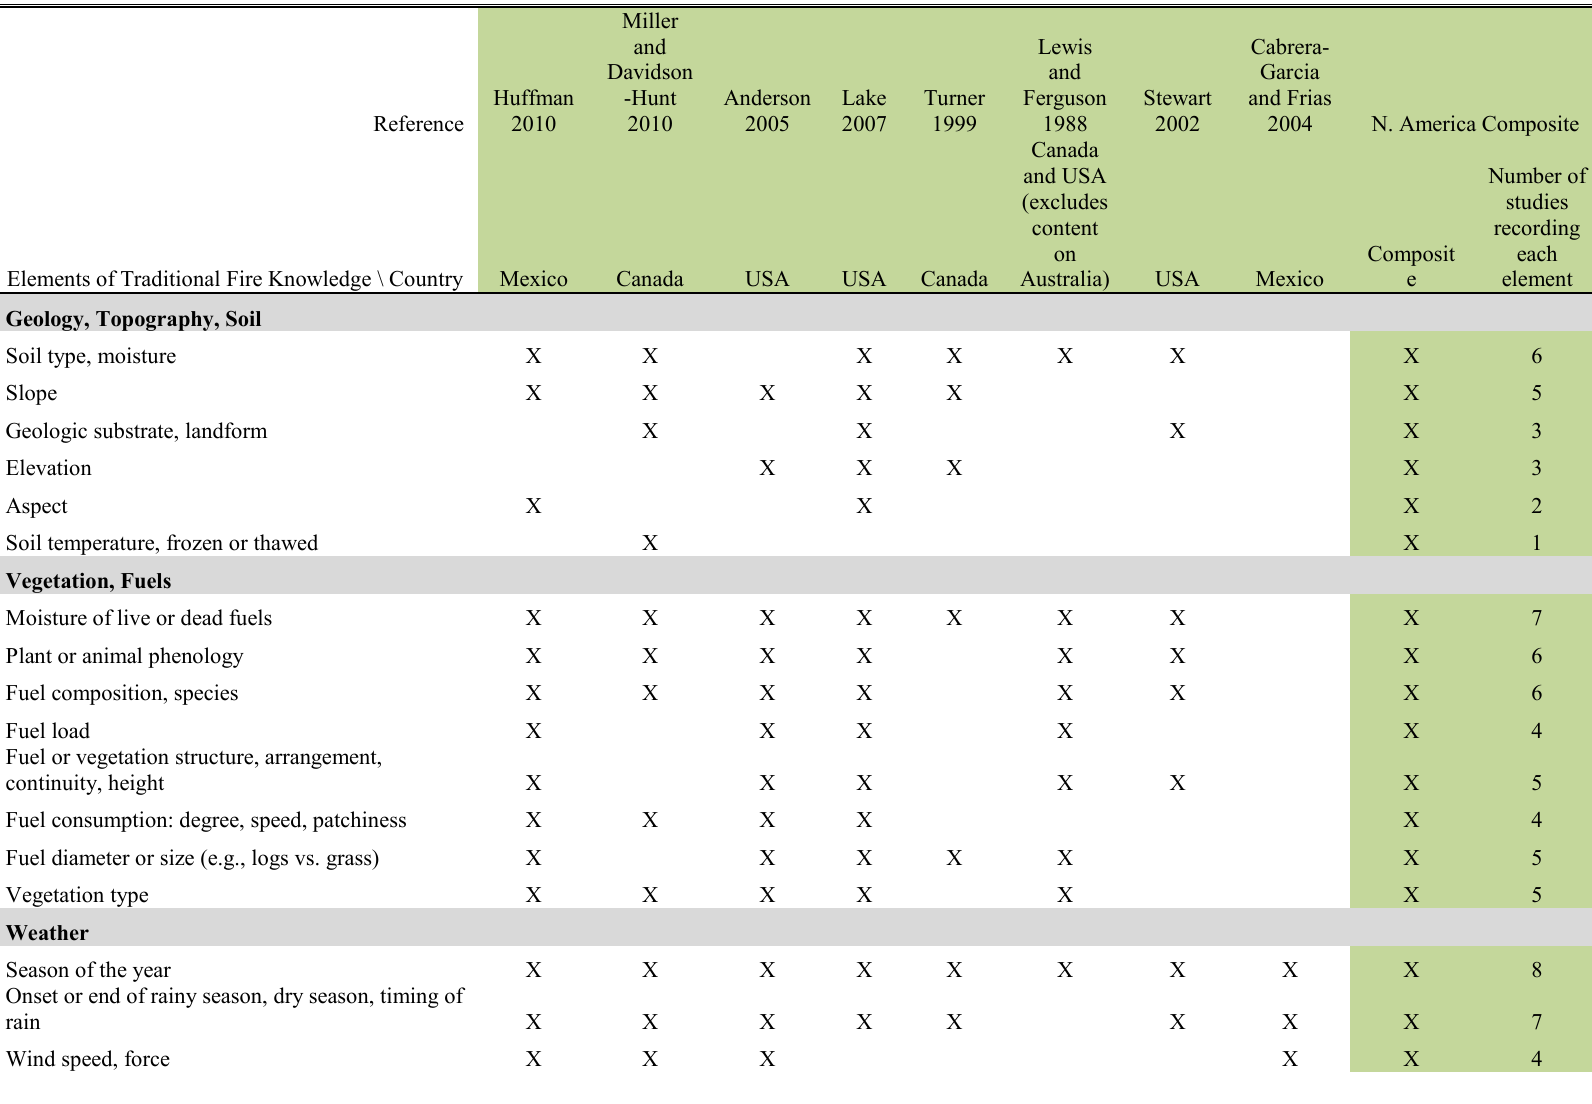
Table A.5. Elements of traditional fire knowledge recorded in studies from North America